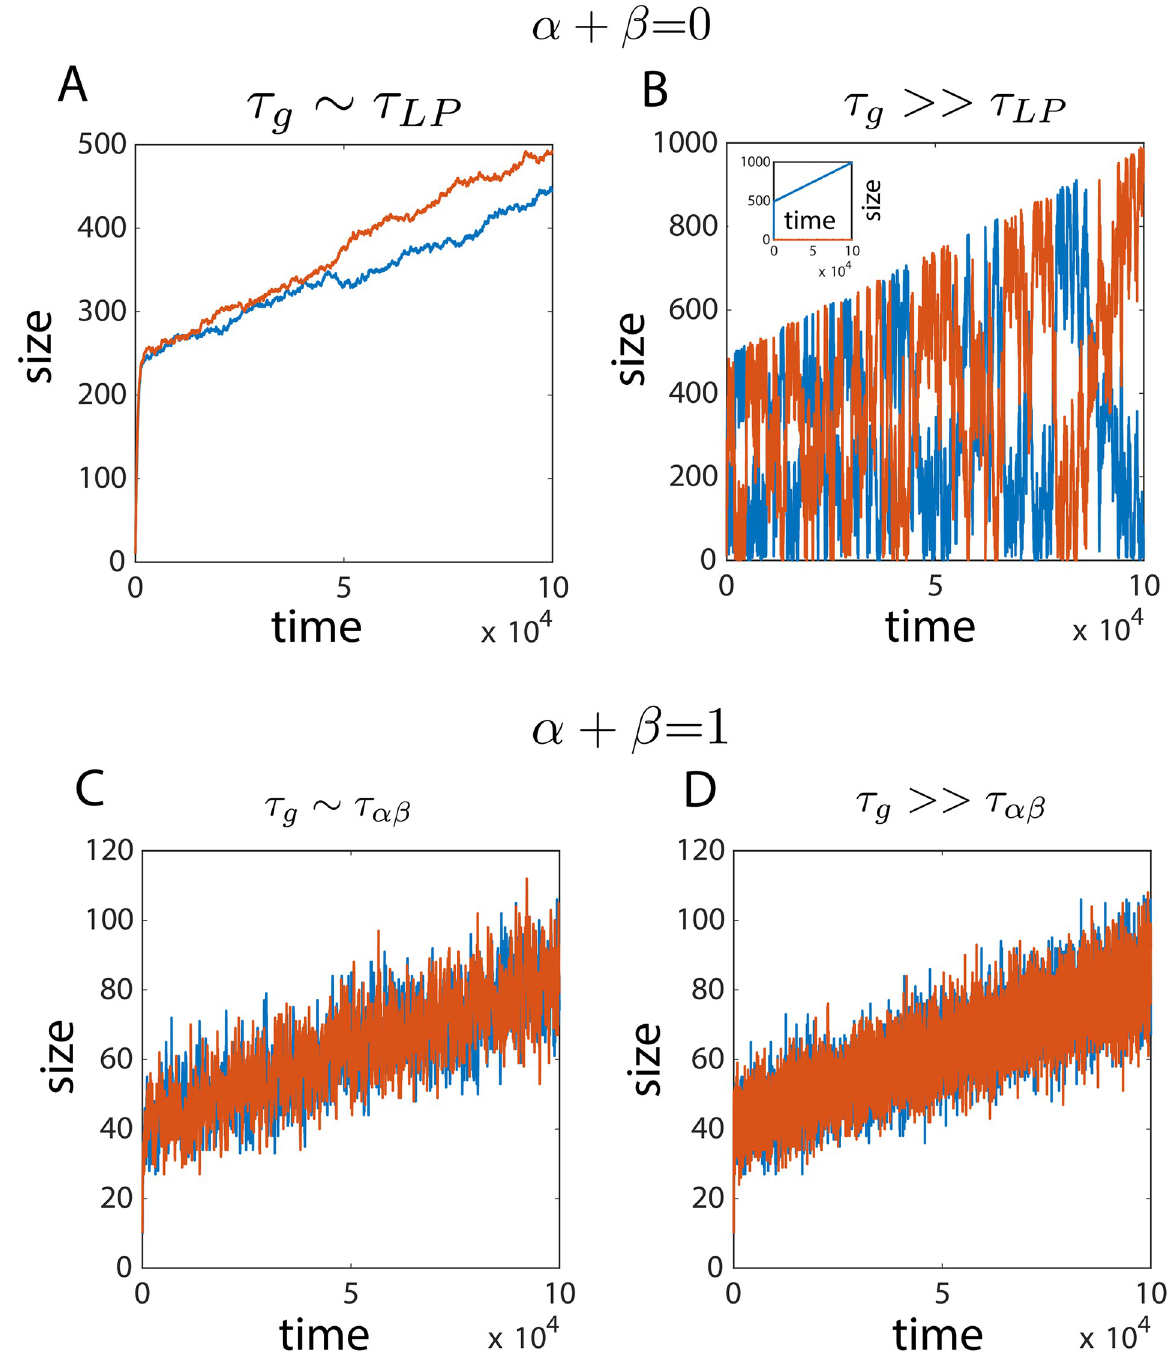
Fig 9. Effect of cellular growth on structure size control. (A,B) In the limiting pool model ( α + β = 0), fast structure growth shows characteristic large fluctuations and loss of size control. In the slow growth regime, transient size control is observed without significant size fluctuations (B, Inset) With difference in growth rates of the structures (e.g., here κ 1 = 2 κ 2 ), a winner-takes-all dynamics ensues and the structure with larger growth rate (blue) increases in size, while the other structure (red) remains small in size. (C,D) The size-dependent growth model ( α + β = 1) provides local temporal control of structure size, with the structure size growing at the same rate as cellular growth.